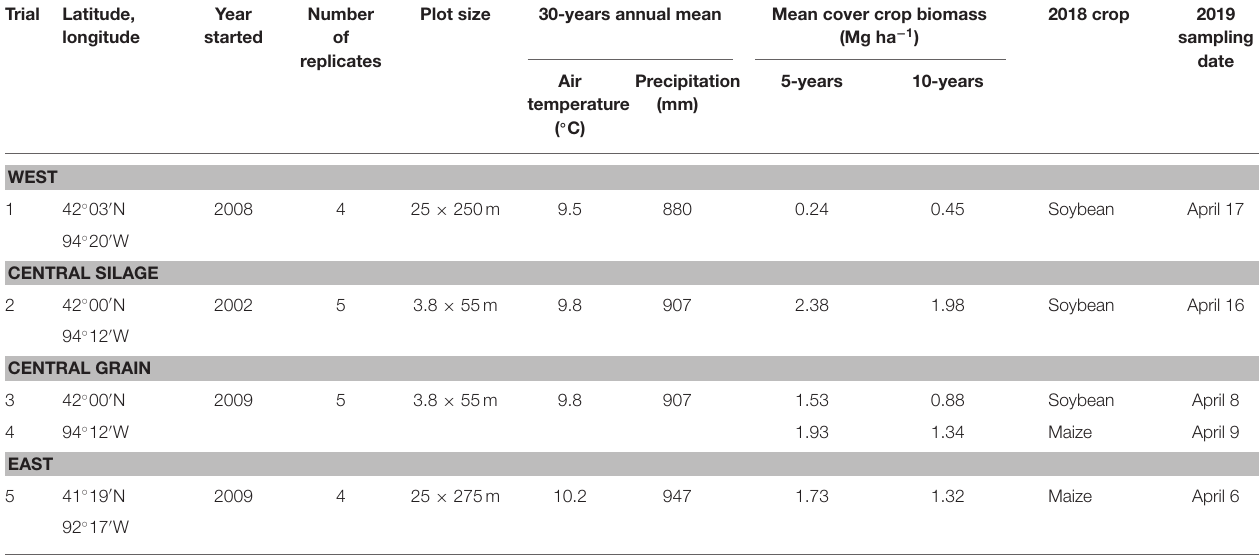
TABLE 1 | Summary of the four trials sampled.